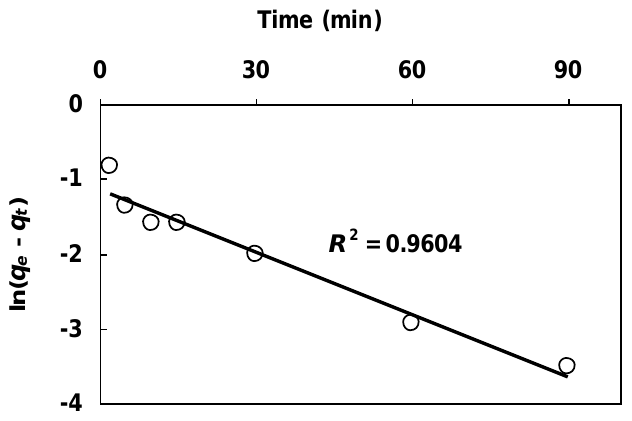
Figure 5. Kinetic data in Figure 4 plotted according to the linearized Lagergren equation (Equation (8)).